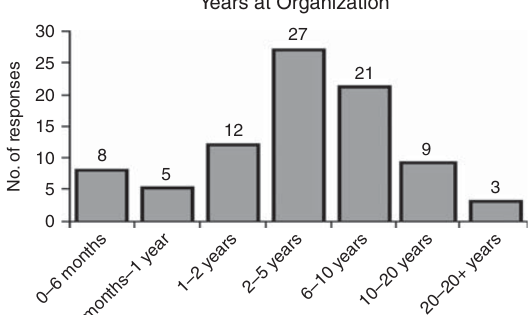
Figure 8. Years at organization of participants as reported